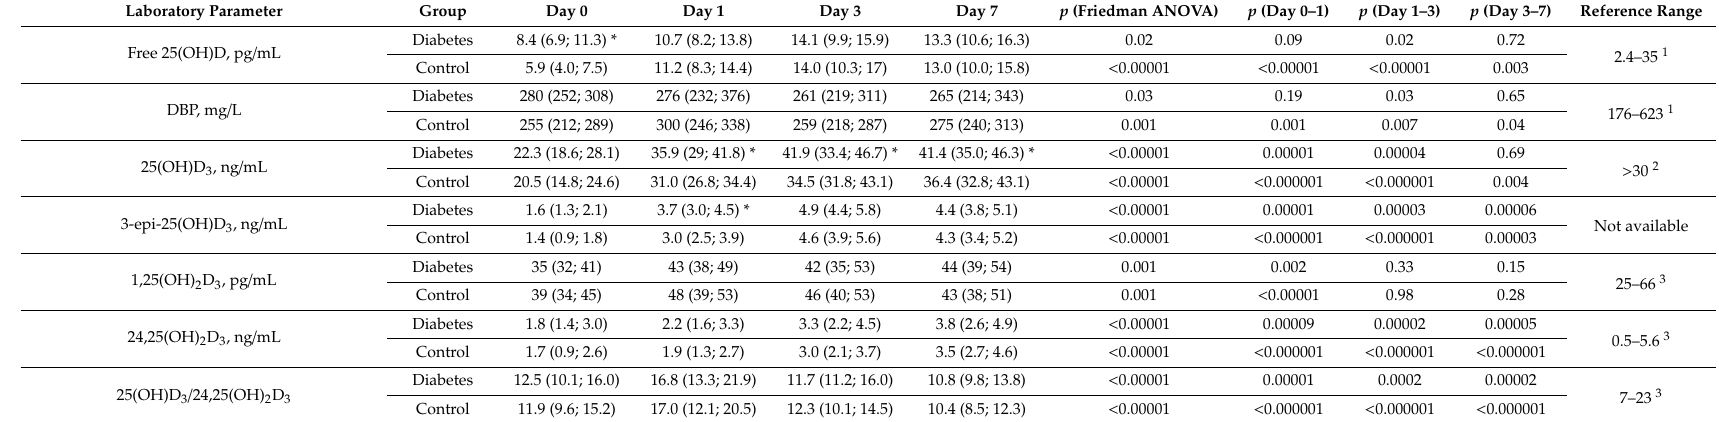
Table 5. Changes in the levels of free 25(OH)D, vitamin D-binding protein (DBP) and vitamin D metabolites during the